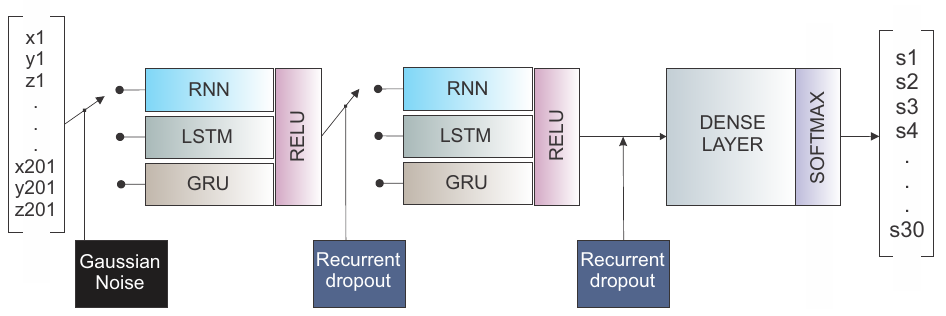
Figure 4. Recurrent neural network